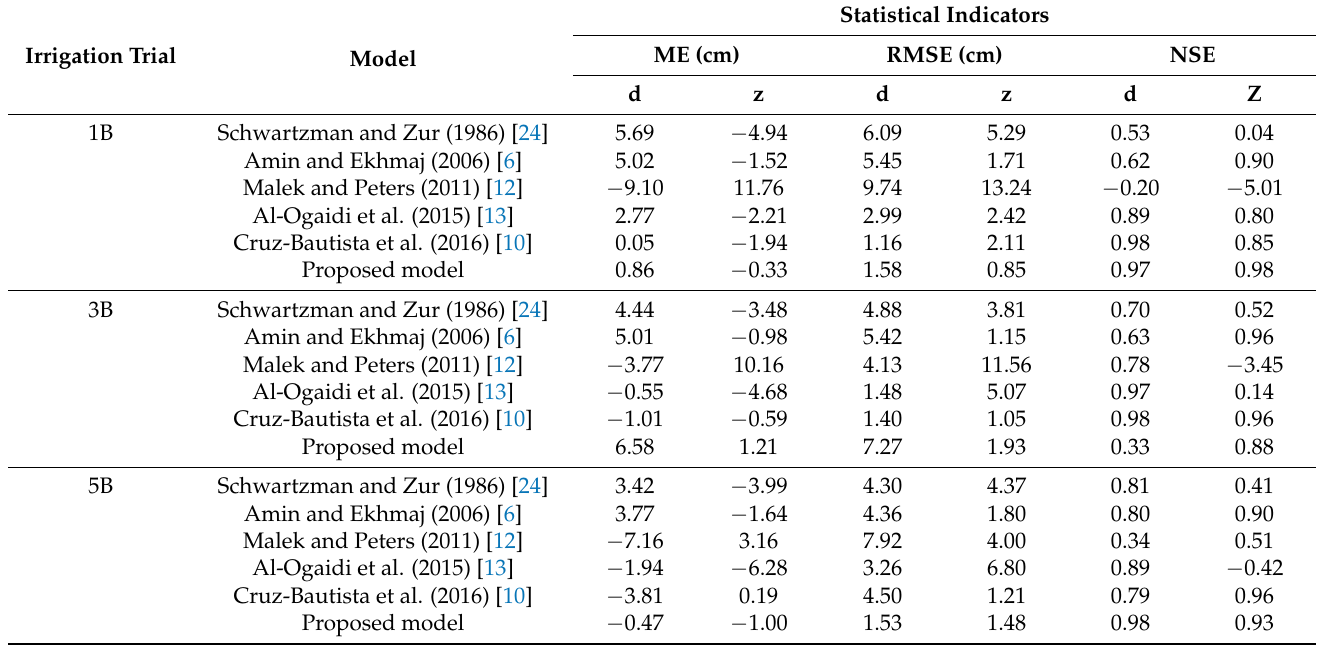
Table 7. Statistical indicators of the empirical models for the second irrigation block, with an emitter discharge rate of 4 L h − 1 , for the width (d) and depth of the wetting front